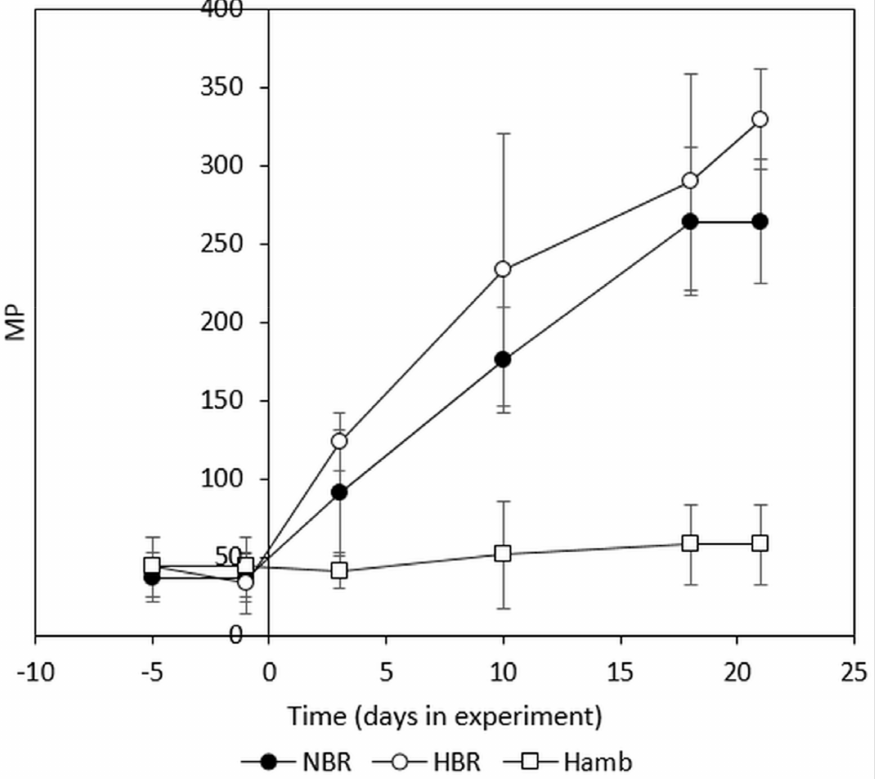
Figure 2. Presentation of MP values for the PlanHab samples in relation to the experimental variants described with BSS (Figure S6). Error bars designate standard deviation. NBR-normoxic bedrest, HBR-hypoxic bedrest, HAmb-hypoxic ambulatory variants of the PlanHab experiment.